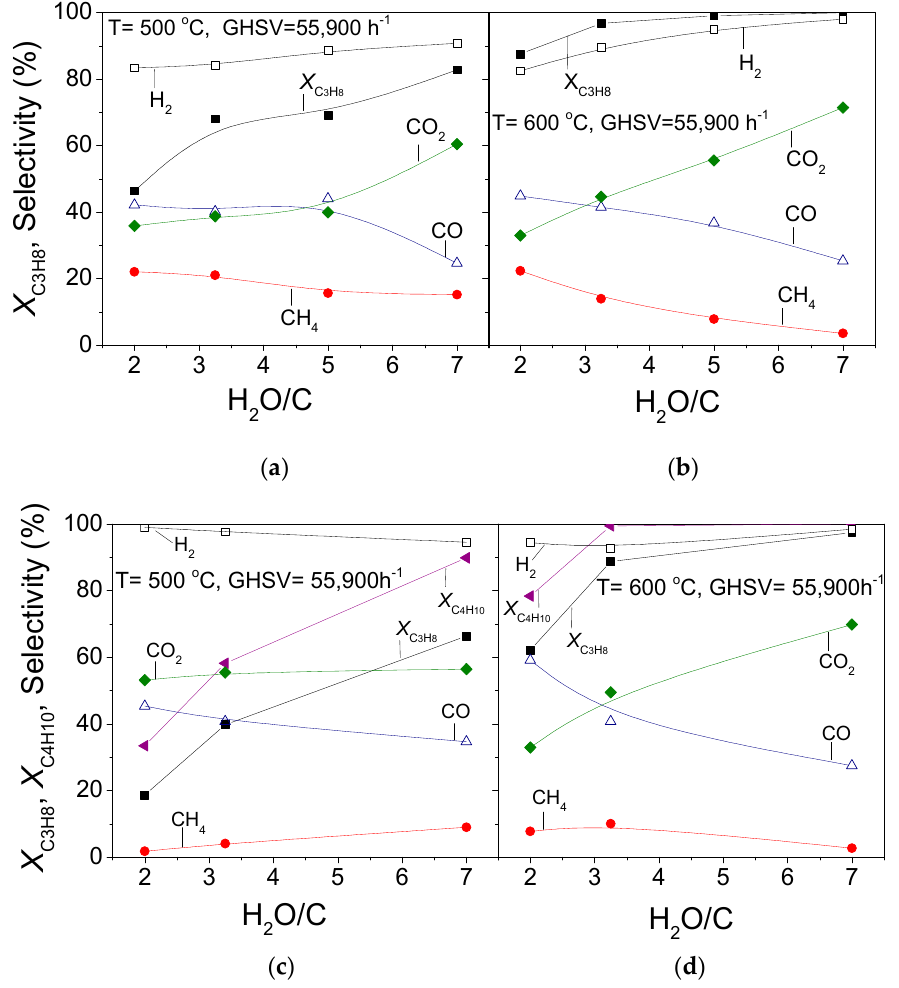
Figure 5. Effect of H 2 O/C on ( a , b ) the conversion of C 3 H 8 and selectivities toward reaction products obtained under conditions of C 3 H 8 steam reforming and ( c , d ) the conversion of propane, conversion of butane, and selectivities toward reaction products obtained under conditions of C 3 H 8 /C 4 H 10 steam reforming over 0.5%Rh/TiO 2 at 500 and 600 °C.